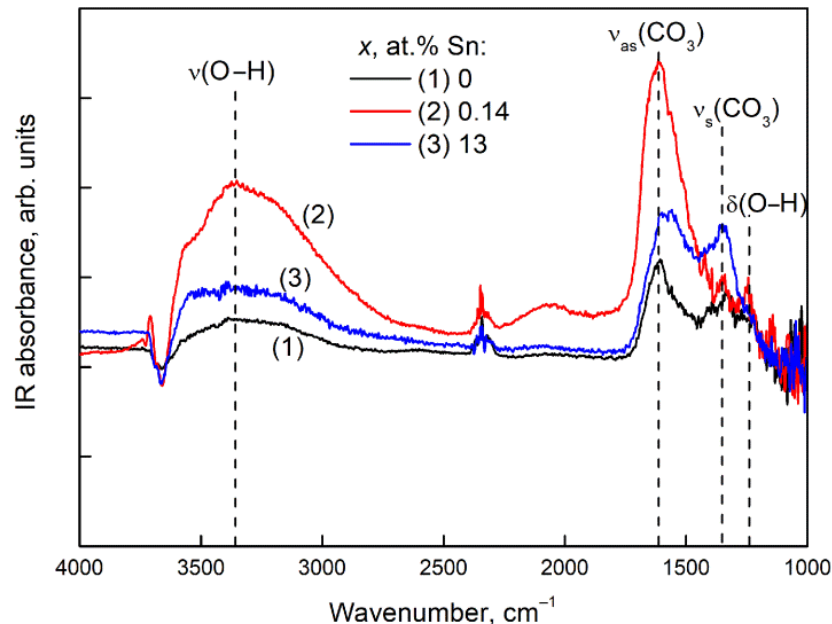
Figure 9. DRIFT spectra of Ga 2 O 3 (Sn) samples after exposure for 1 h in CO 2 (500 ppm) in air at room temperature: ( 1 ) 0, ( 2 ) 0.14, ( 3 ) 13 at.% Sn.